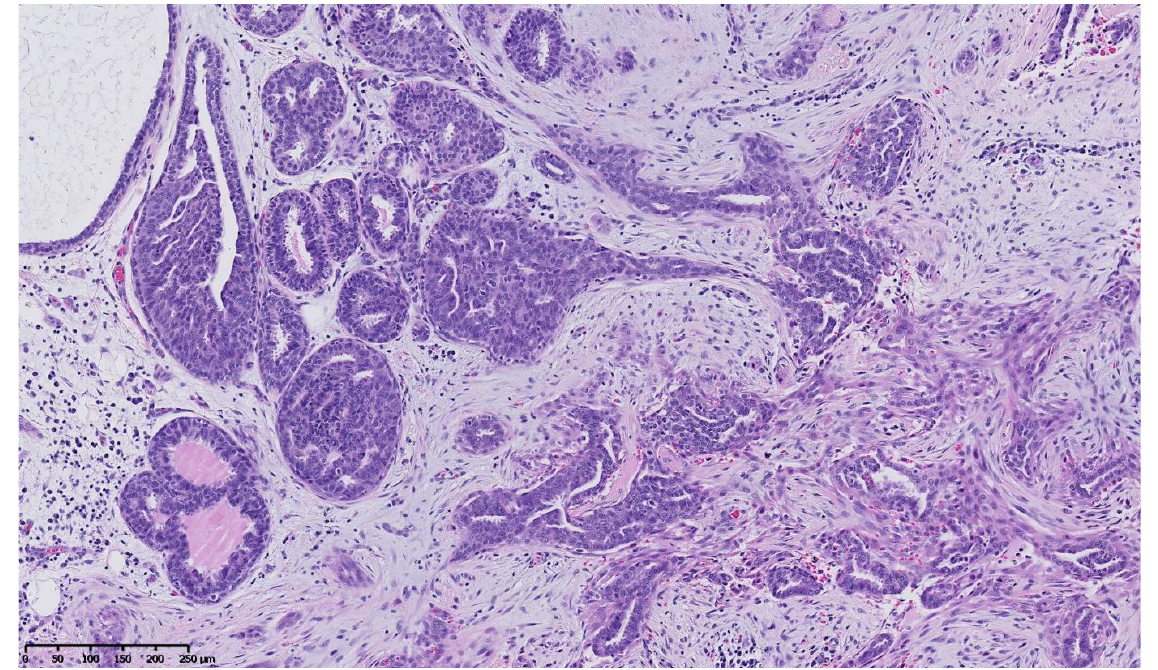
Figure 3. Hematoxylin and eosin staining: at low magnification, the breast parenchyma shows a fibrous stroma containing an irregularly shaped lesion with a fibro-myxoïd dense stroma and inflammatory changes containing cystic ducts and hyperplastic ducts.